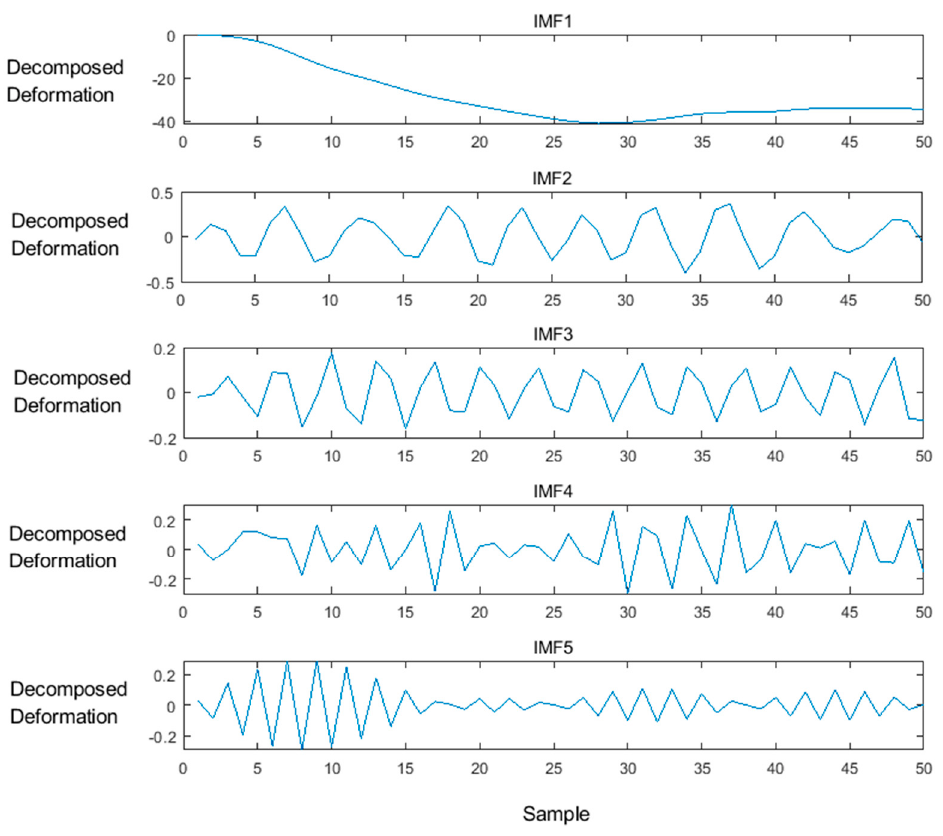
Figure 7. Decomposition results of ZD13 via EWT.